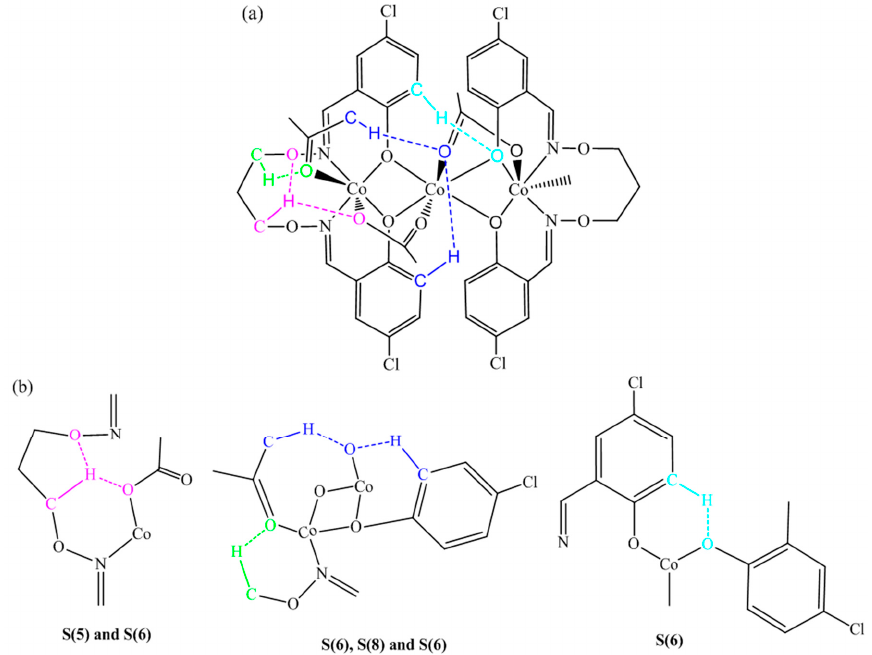
Figure 5. ( a ) Graph set assignments for coordination compound 1 ; ( b ) partial enlarged drawing of hydrogen bonds.